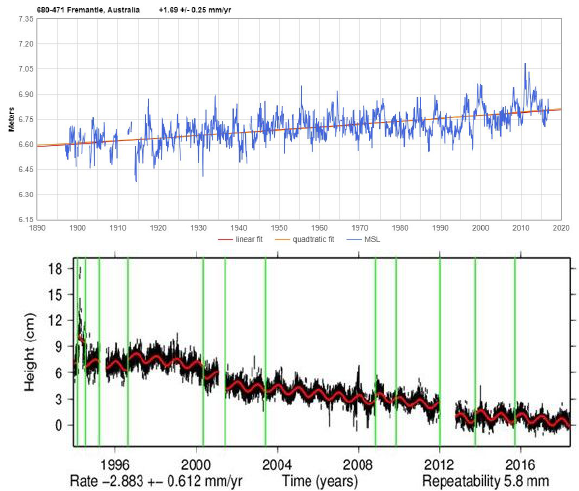
Figure 3: MSL (top) and GPS (bottom) data for Fremantle. Images reproduced and modified after http://www.sealevel.info/ and